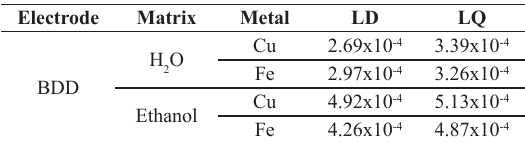
Table 8. LD and LQ obtained for the BDD micro/nano electrode in water and